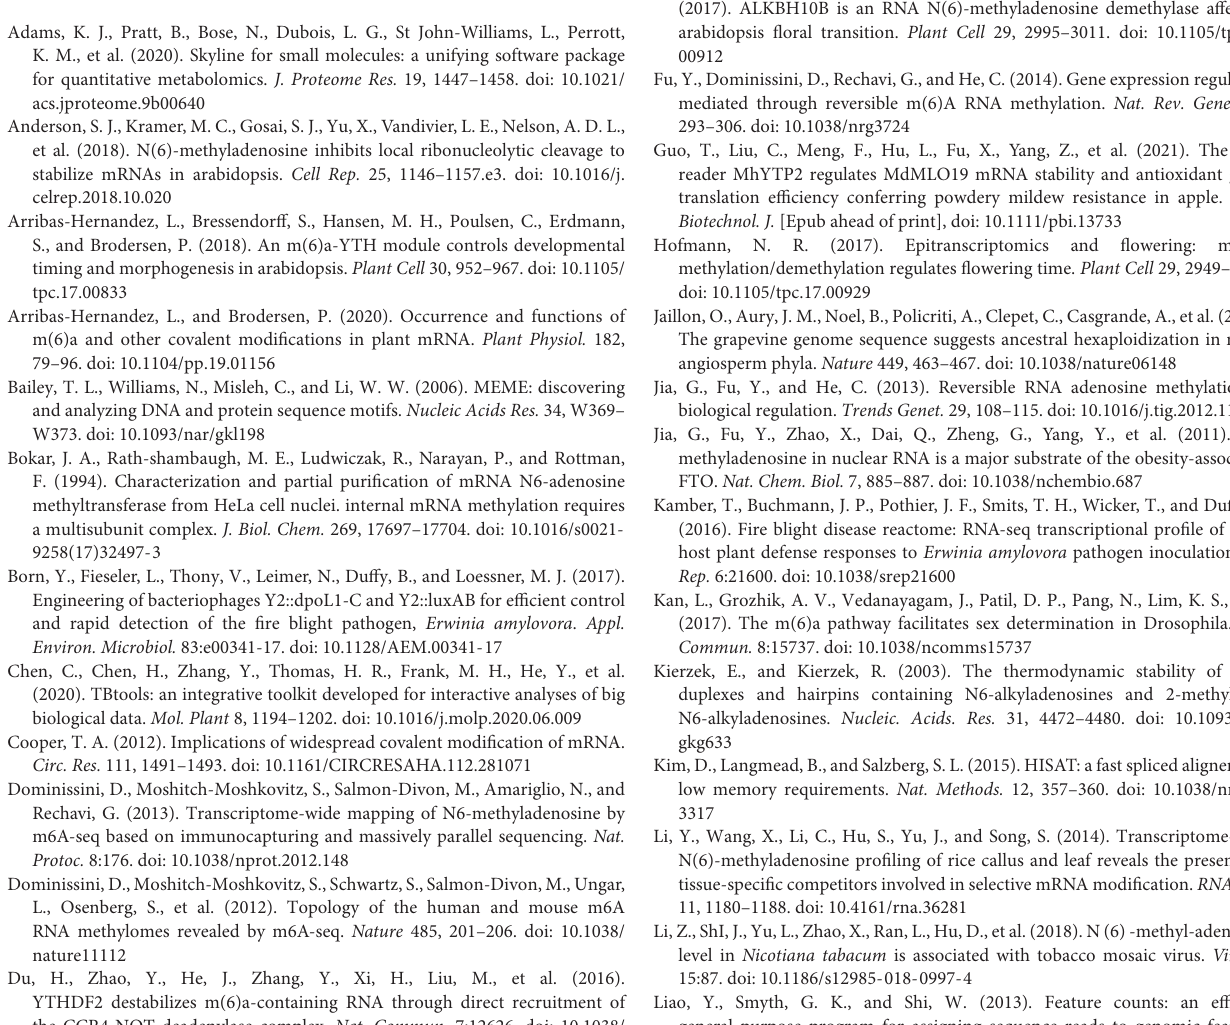
Supplementary Figure 4 | Evidence for coevolution of m 6 A modifications and gene duplication. (A) Comparison of ratios of m 6 A gene pairs and non-m 6 A gene